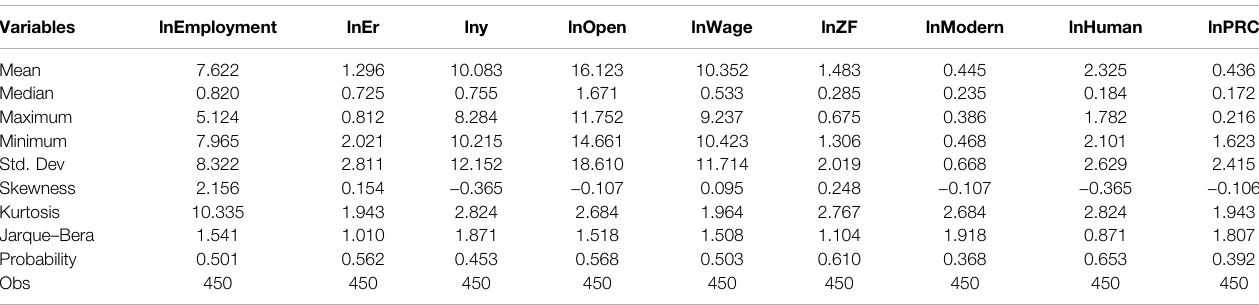
TABLE 2 | Statistical characteristics of variables.